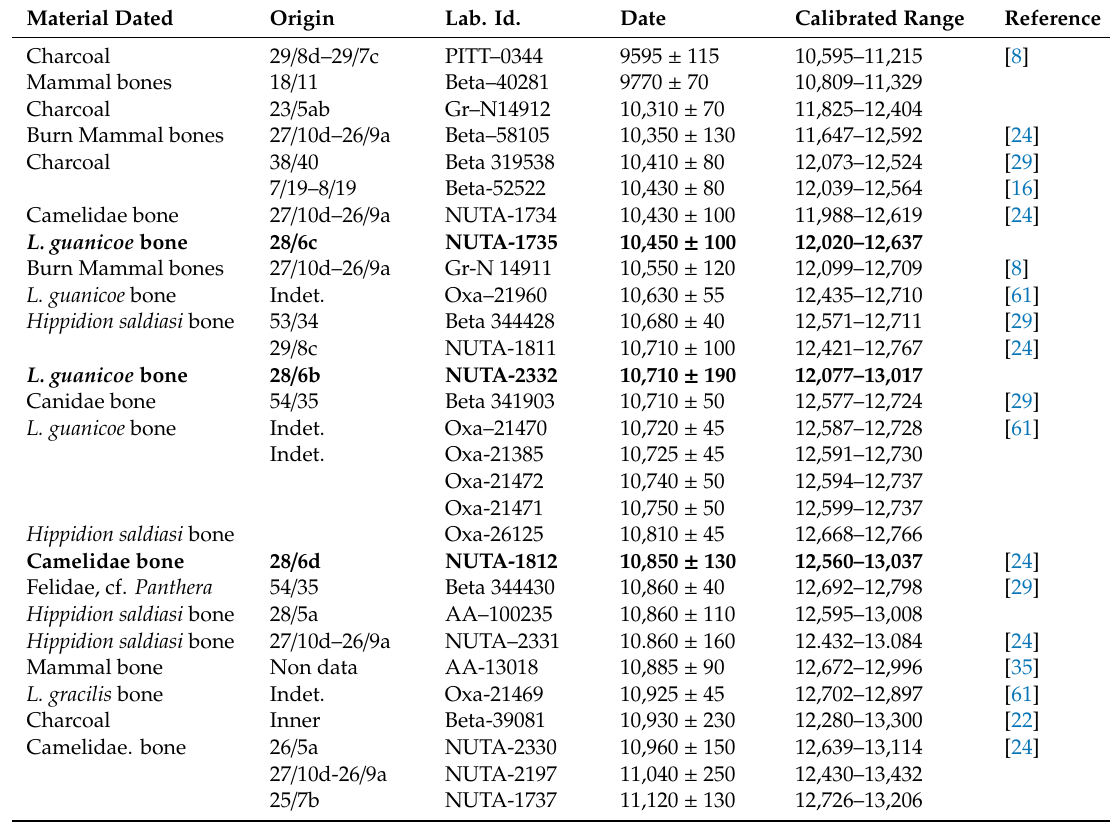
Table 1. List of AMS dates corresponding to the Pleistocene–Holocene transition obtained at CM. The dates in bold fonts comes from a level with mix of triangular